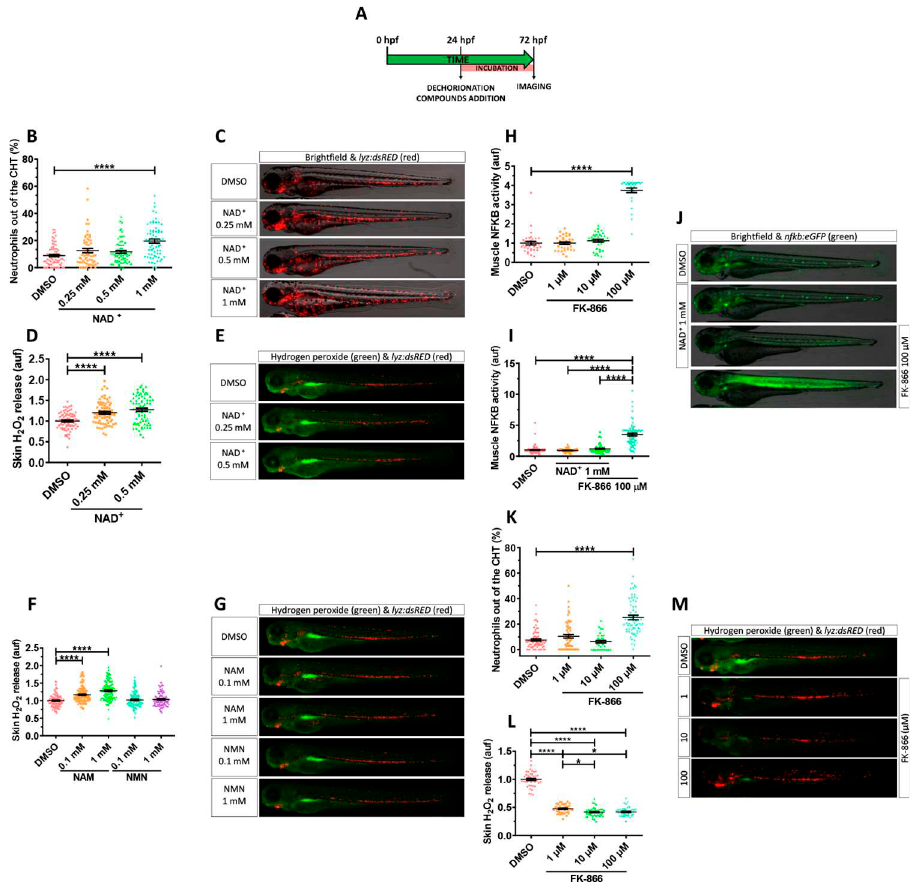
Fig 1. NAD + metabolites regulate skin oxidative stress and inflammation. (A) Embryos of 24 hpf were manually dechorionated, treated for 48 hours with NAD + metabolites or FK-866 by bath immersion, and images obtained at 72 hpf. (B–M) Quantification of the percentage of neutrophils out of the CHT in embryos treated with NAD + (0.25, 0.5 and 1 mM) (B). Representative merge images (brightfield and red channel) of lyz : dsRED zebrafish larvae of every group are shown (C). For H 2 O 2 imaging, embryos were incubated in 50 μ M of acetyl-pentafluorobenzene sulphonyl fluorescein solution for 1 hour. Quantification of fluorescence intensity for NAD + -mediated (D) and NAM-/NMN- mediated (F) induction of H 2 O 2 in the zebrafish skin. Representative merge images (green and red channel) of lyz : dsRED zebrafish larvae of every group are shown (E, G). NFKB activity was determined by quantification of fluorescence intensity in embryos treated with increasing doses of FK-866 (1, 10, and 100 μ M) (H). Additionally, the influence of NAD + in the presence or absence of 100 μ M FK-866 was assayed (I). Representative images (brightfield and green channel) of nfkb : eGFP zebrafish larvae of every group are shown (J). Neutrophil distribution in zebrafish embryos of 3 dpf treated with FK-866 (K), quantification of skin H 2 O 2 production (L), and representative merge images (green and red channel) of lyz : dsRED zebrafish larvae of every group are shown (M). Each dot represents 1 individual and the mean ± SEM for each group is shown. p -Values were calculated using 1-way ANOVA and Tukey multiple range test. � p � 0.05, ���� p � 0.0001. The data underlying this figure can be found in S1 Data. ANOVA, analysis of variance; CHT, caudal hematopoietic tissue; NAD+, nicotinamide adenine dinucleotide; NAM, nicotinamide; NMN, nicotinamide mononucleotide.